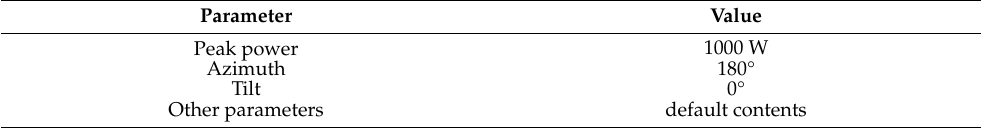
Table 2. PV system parameters.